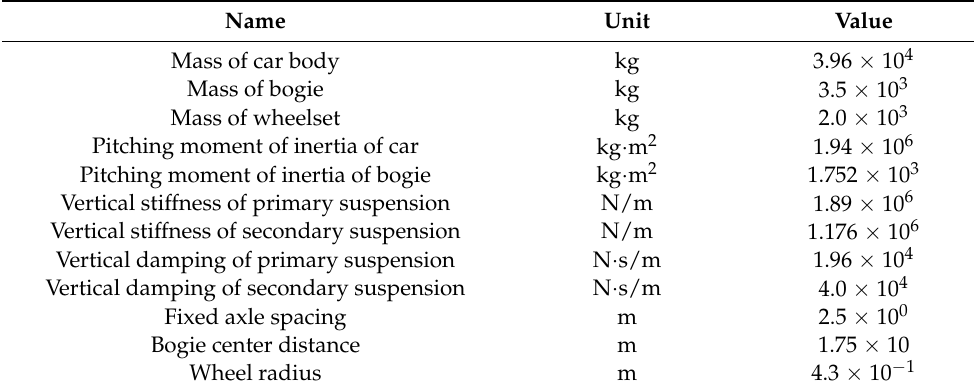
Table 2. The main parameters of the China Railway High-speed (CRH) 2 vehicle.